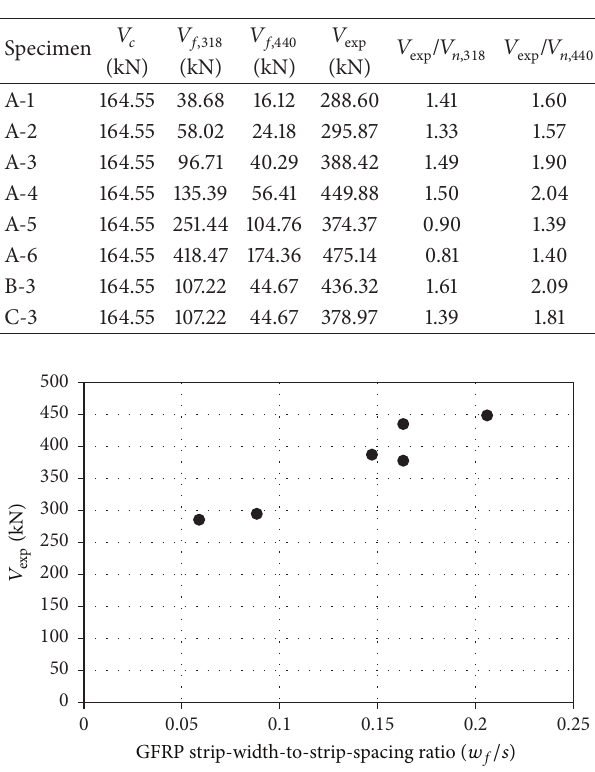
Figure 13: Effect of the GFRP strip-width-to-spacing ratio on shear